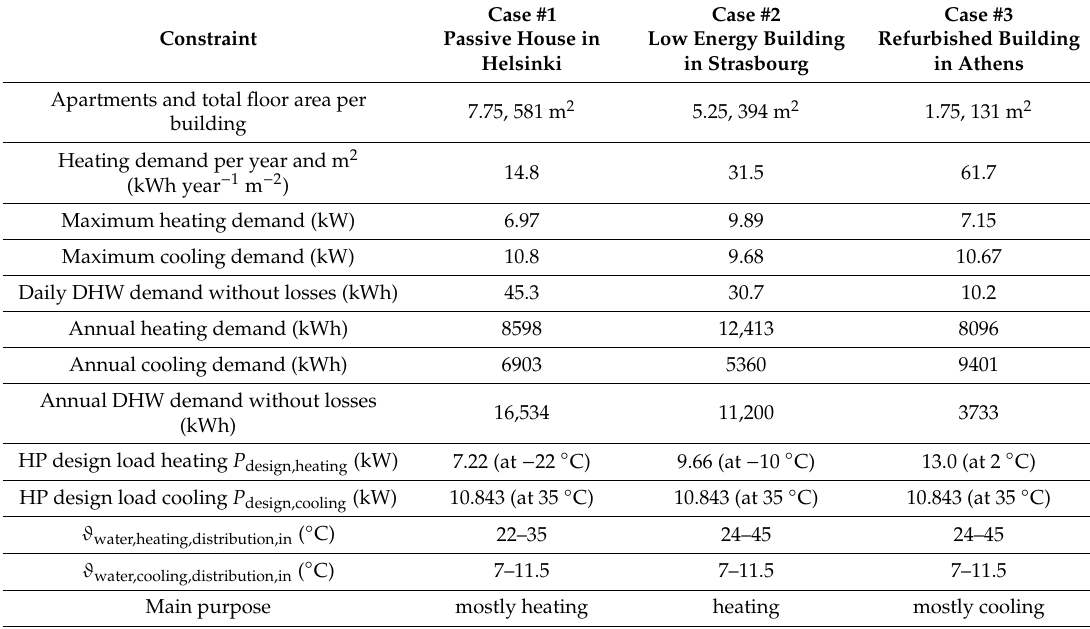
Table 1. Constraints of the case